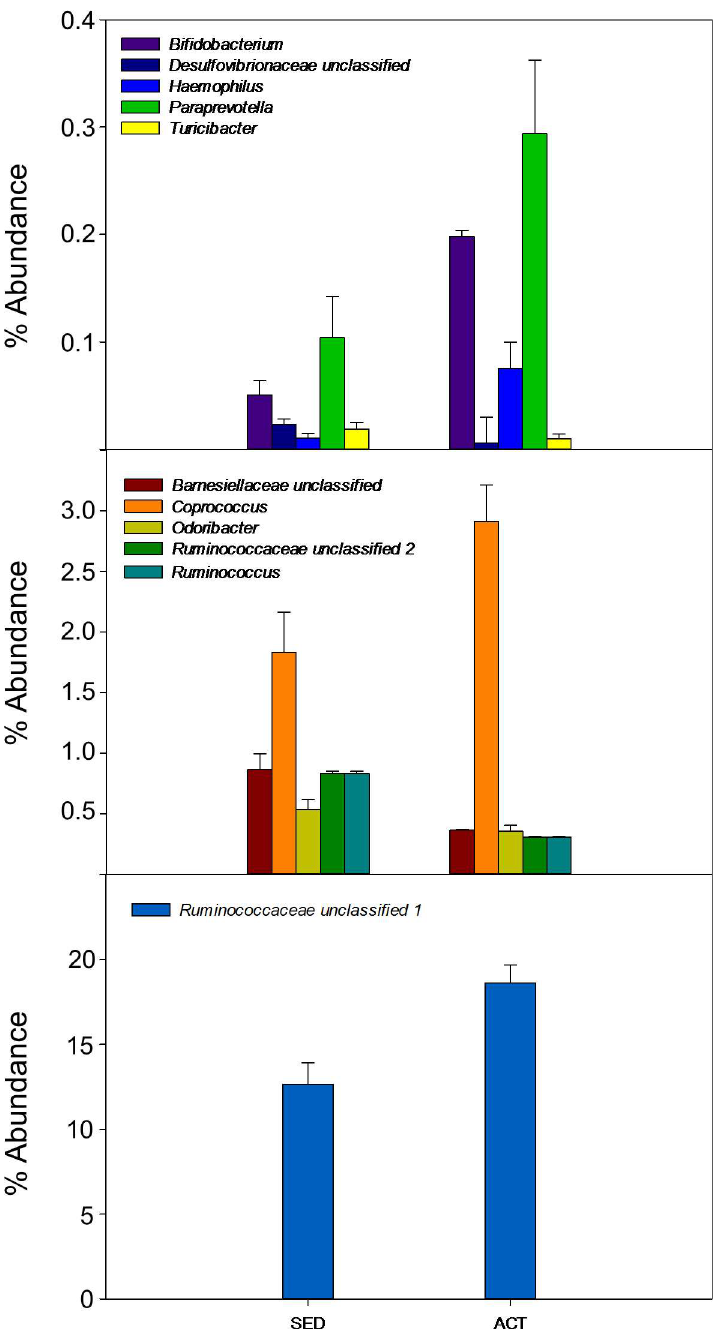
Fig 2. Abundance of different bacterial genera in fecal microbiota of active and sedentary women. Only statistical significantgenerawith an adjustedvalue p < 0.001are represented.